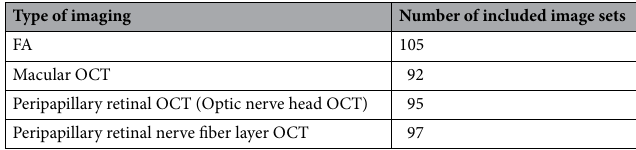
Table 1. Number of available image-sets for each imaging modality.